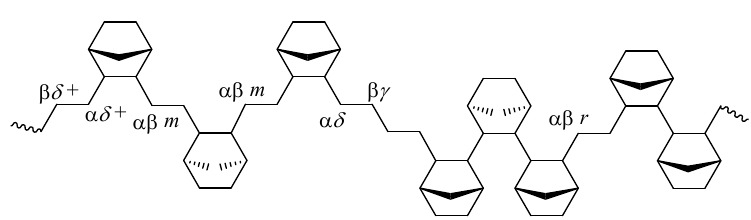
the metallocene and half-titanocene precatalysts, used along with methylaluminoxane (MAO) cocatalyst for the synthesis of copolymers whose microstructure will be elucidated, are displayed.